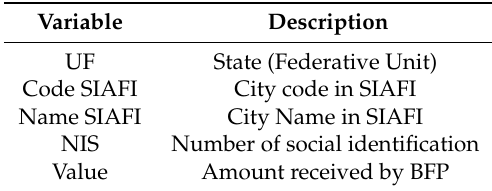
Table 3. Variables of the monthly payment bases for